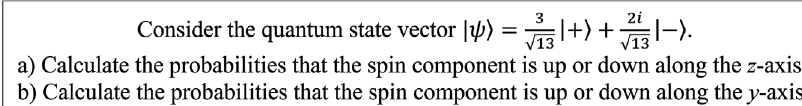
FIG. 1. The interview questions analyzed in this